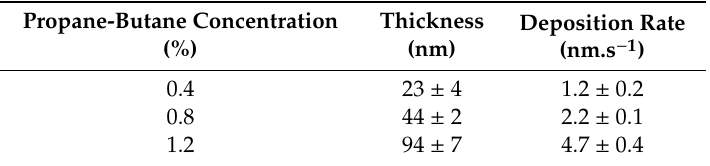
Table 3. Dependence of thickness of coatings of samples deposited for 20 s and calculated deposition rate on the volume concentration of P-B in processing gas.